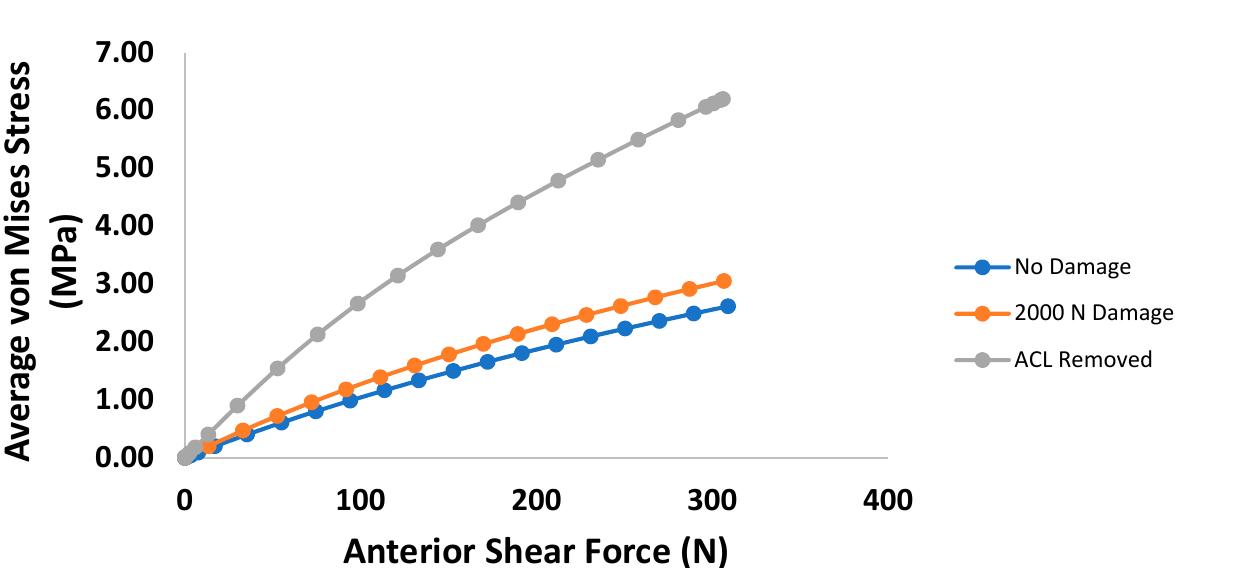
Figure 7. Plot of average PCL mid-substance von Mises stress (MPa) versus anterior shear force for the three prescribed damage cases.